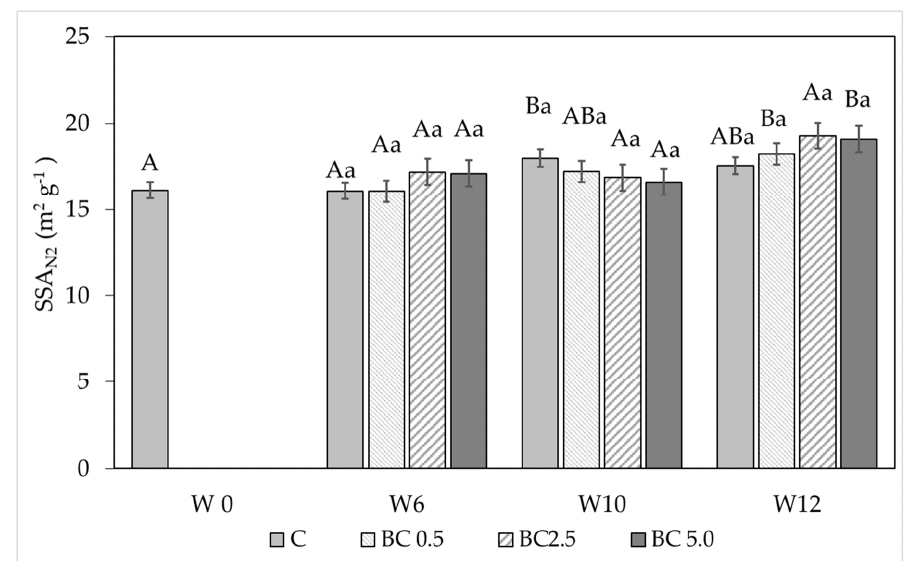
Figure 4. Changes in SSA N2 over time for the di ff erent treatments. C, BC0.5, BC2.5, and BC5.0 represent control, 0.5%, 2.5%, and 5.0% biochar amended soil, respectively. W represents the number of weeks during sampling periods. Means denoted by the same letter are not significant at p < 0.05; lowercase letters denote the comparison within biochar treatments, while uppercase letters compare the means in Agronomy 2020 , 10 , x FOR PEER REVIEW the sampling periods.